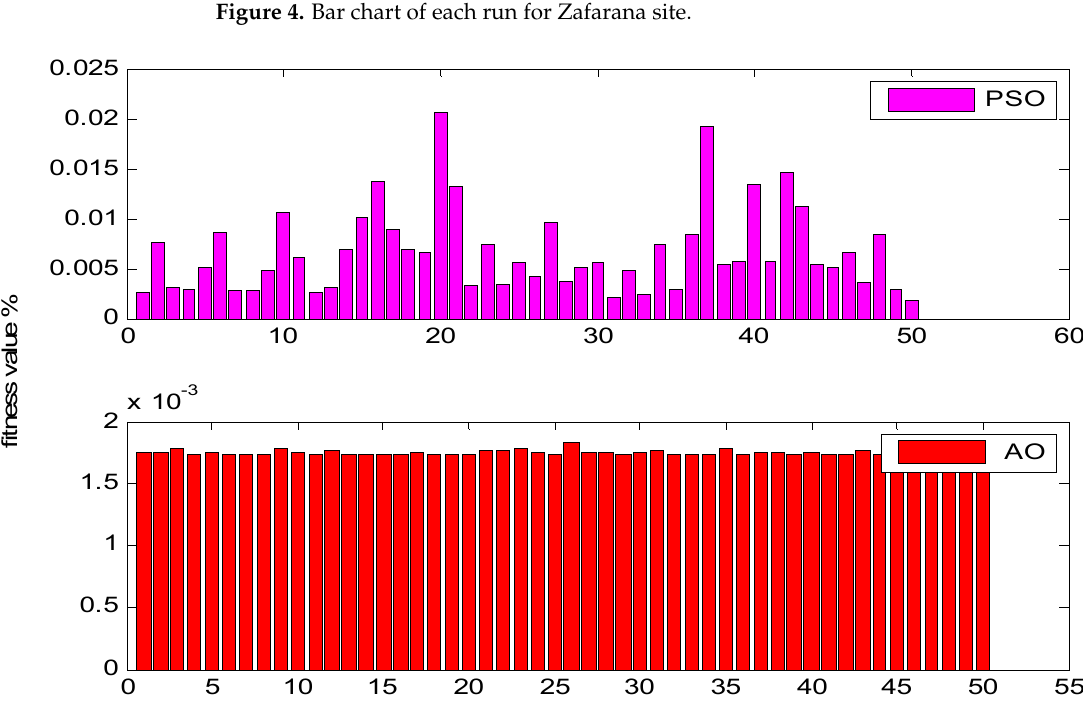
Figure 5. Bar chart of each run for Shark El-Ouinate site.